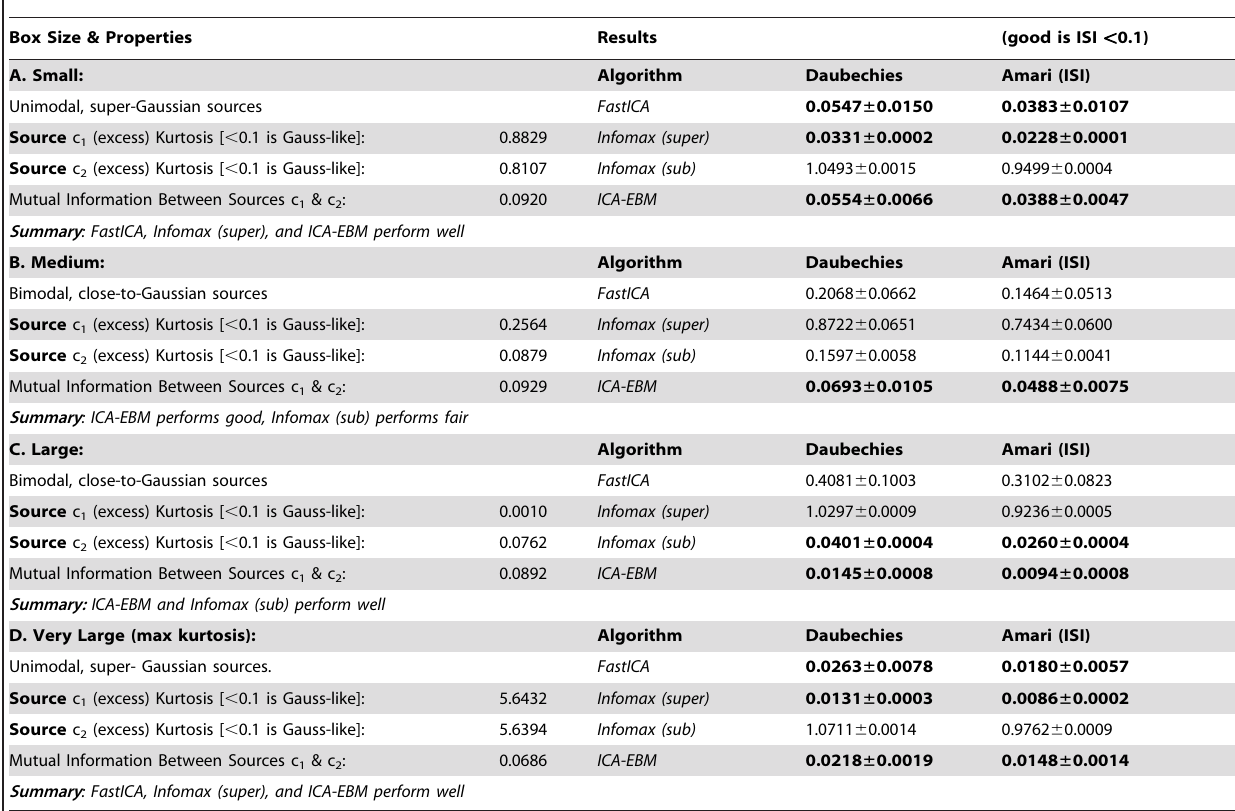
Table 1. Source estimates for the four cases indicated in Figure